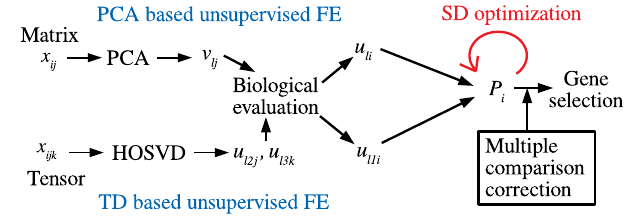
Figure 1. Schematic figure of TD- and PCA-based unsupervised FE with optimized